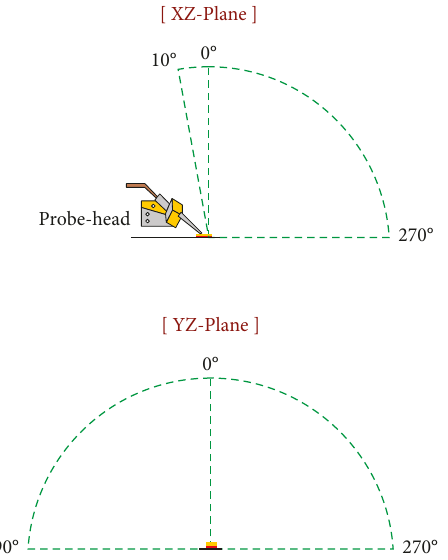
Figure 8: Scannable angular sectors for XZ plane and YZ plane.